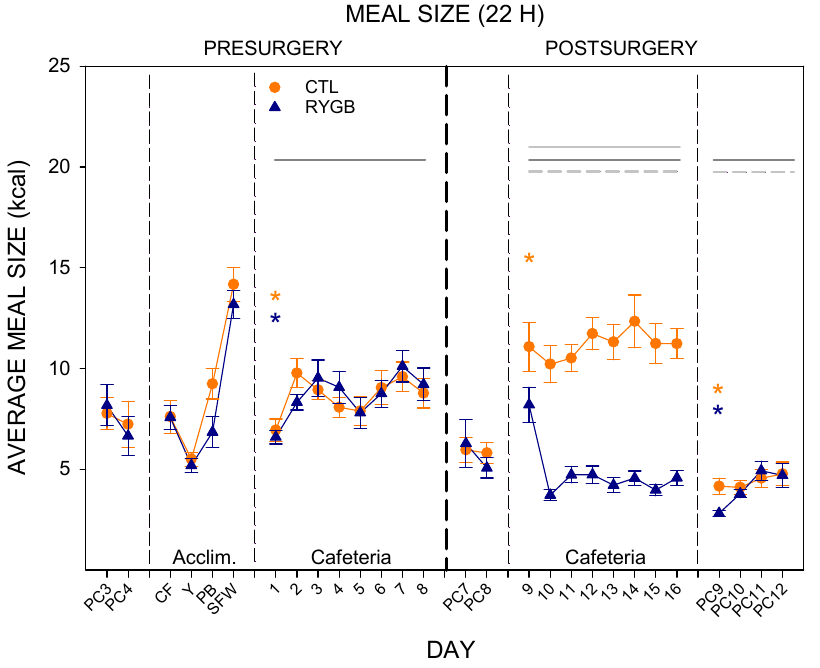
12 of 42 and RYGB ( n = 11; blue triangles). Inset: results from two-way mixed ANOVAs (G: group, D: day, G × D: group × day), with significant results in bold. 3.2. Meal Patterns across the 22-h Period Pre-surgically, meal sizes on the cafeteria diet changed significantly across days, with the lowest average meal size occurring on the first day of the cafeteria diet (Figure 6; Ta- bles 4 and 5). This is perhaps not surprising, given the large quantity of yogurt consumed